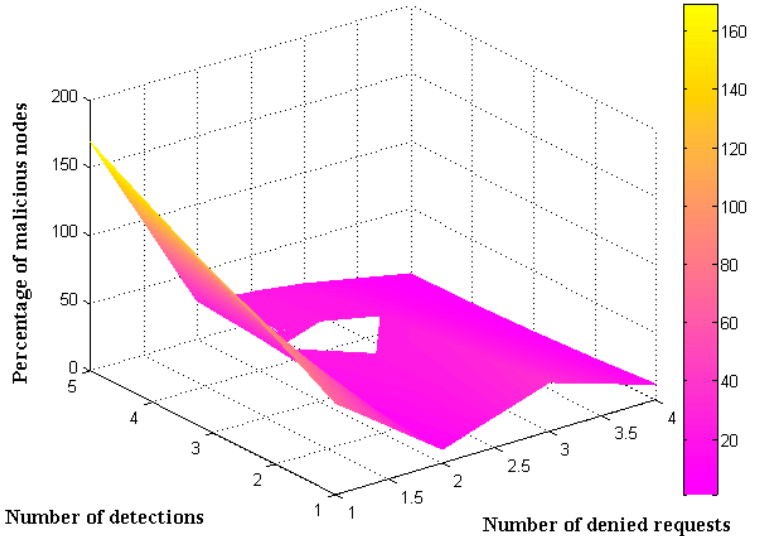
Figure 4. Detection of malicious nodes.